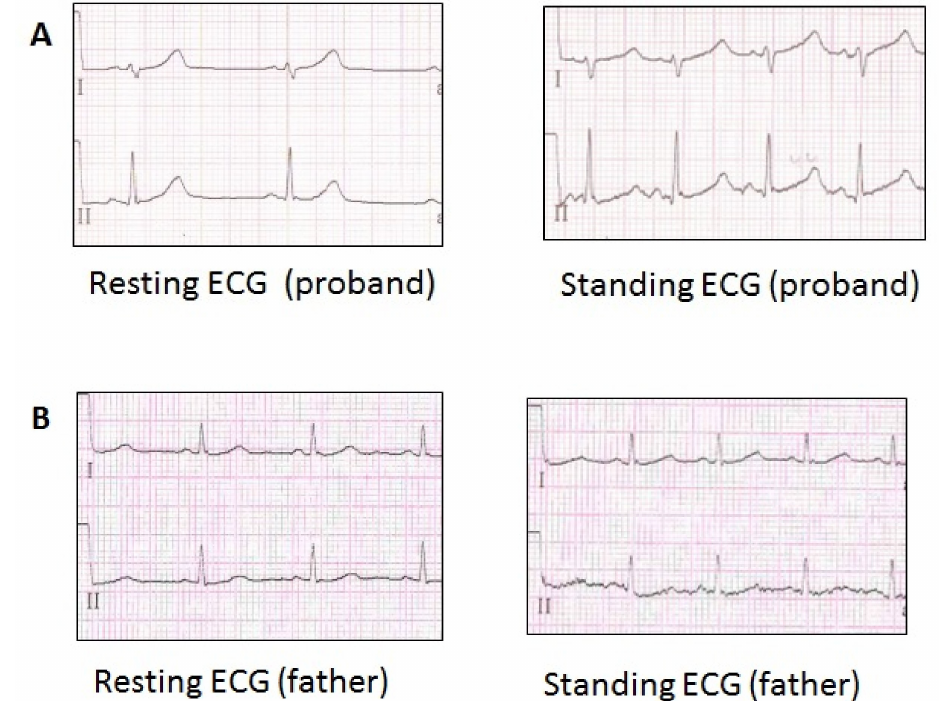
Figure 3. ECG of the family LQTS_139 members, carriers of the p.Val93Ile variant in the KCNJ2 gene. ( A ) ECG fragment of the proband (Resting HR 59 bpm, QTc 449 ms), (Standing HR 103 bpm, QTc 568 ms). ( B ) ECG fragment of the proband’s father (Resting HR 78 bpm, QTc 458 ms), (Standing HR 97 bpm, QTc 467